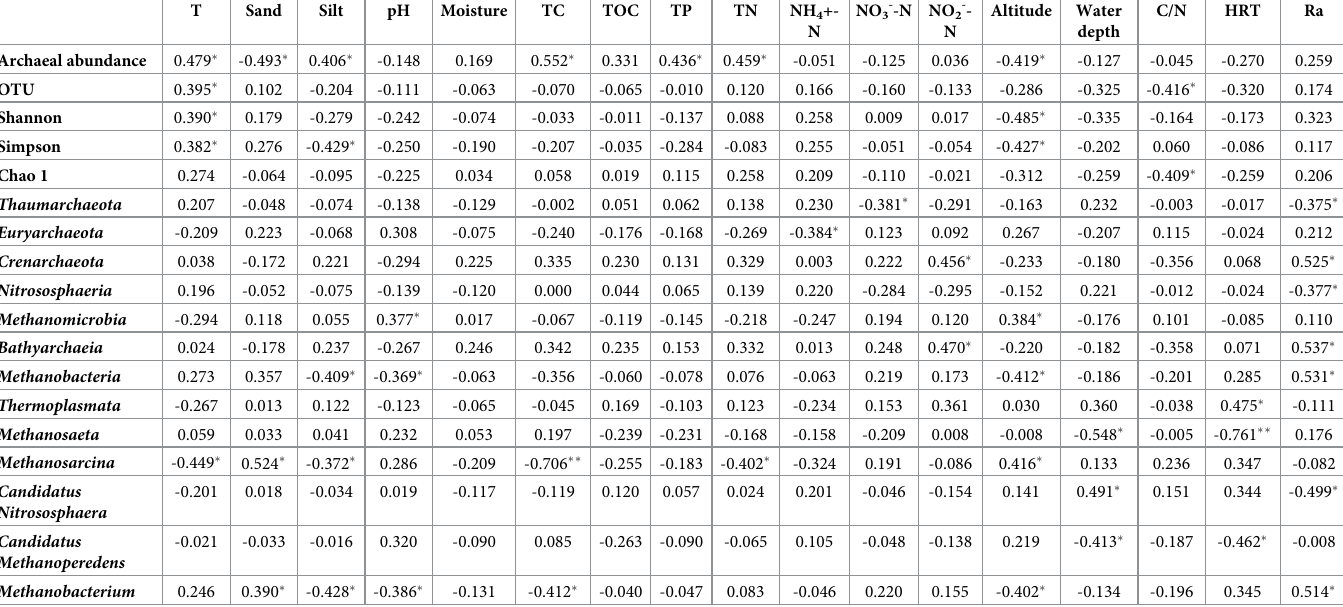
Table 1. Spearman correlation analysis of archaeal communities with environmental